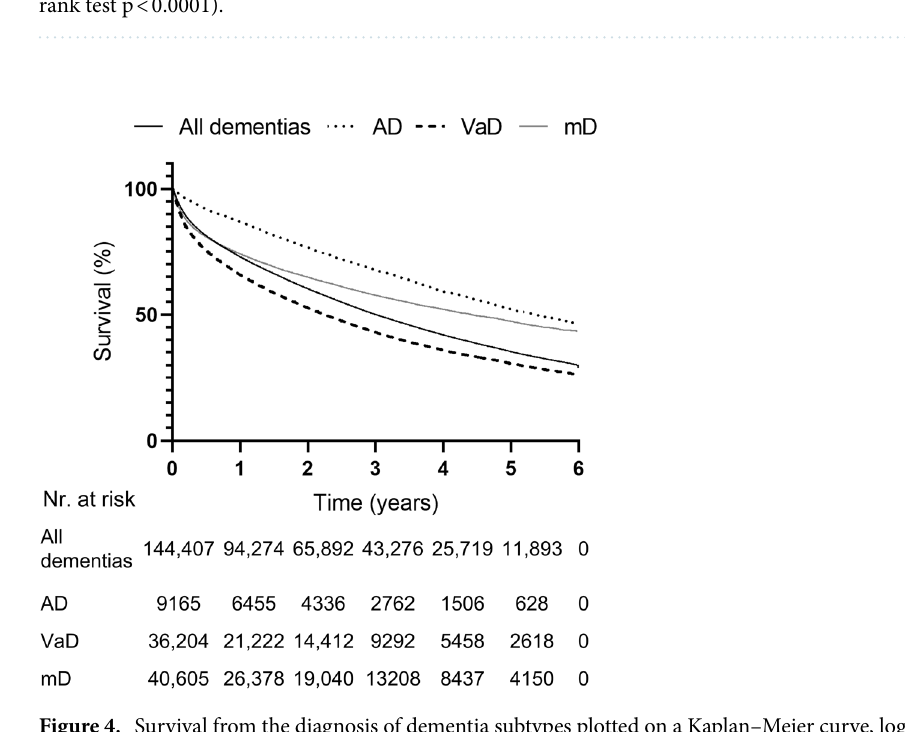
Figure 4. Survival from the diagnosis of dementia subtypes plotted on a Kaplan–Meier curve, logrank test p <